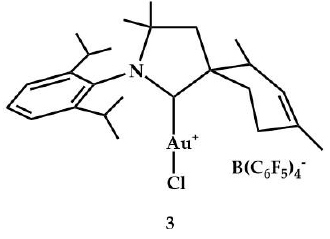
Figure 3. Cationic gold(I) complex 3 .